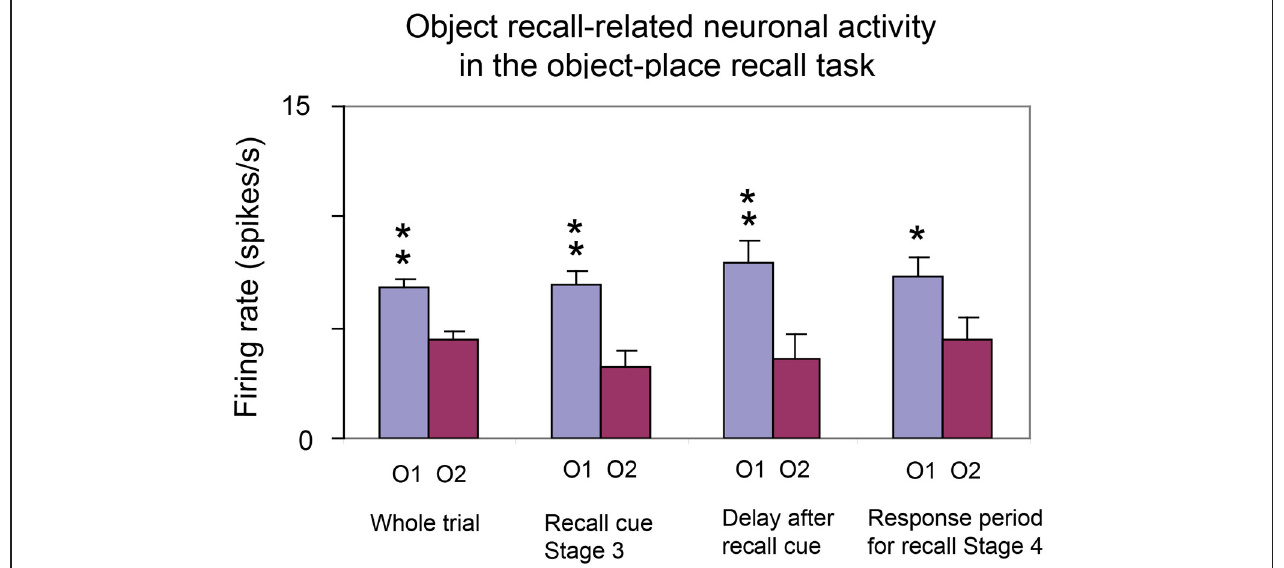
FIGURE 6 | Activity of a neuron with responses related to one of the objects used in the object-place recall task. The firing rate to object 1 (O1) and object 2 (O2) are shown (mean firing rate in spikes/s across trials ± sem). The first histogram pair (on the left) shows the responses to the two objects measured throughout the trial whenever object 1 or object 2 was on the screen. The second histogram pair shows the neuronal responses when the objects were being shown in stage 3 as the recall cue. The third histogram pair shows the neuronal responses in the 0.5s delay period after one of the objects had been shown in stage